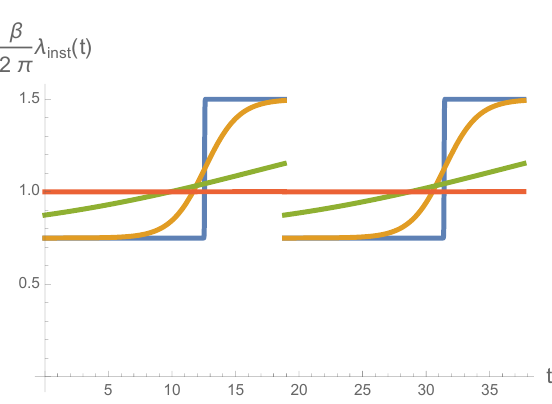
Figure 15 . The instantaneous Lyapunov exponent (cid:21) inst ( t ) as a function of time. We set ^ ! = (cid:21) t ) for (cid:12) ! 0 (blue), 2 (cid:25) (orange), 16 (cid:25) (green), and 1 1 = 3 ; ‘ = 1 and plot (cid:12) inst ( 2 (cid:25)